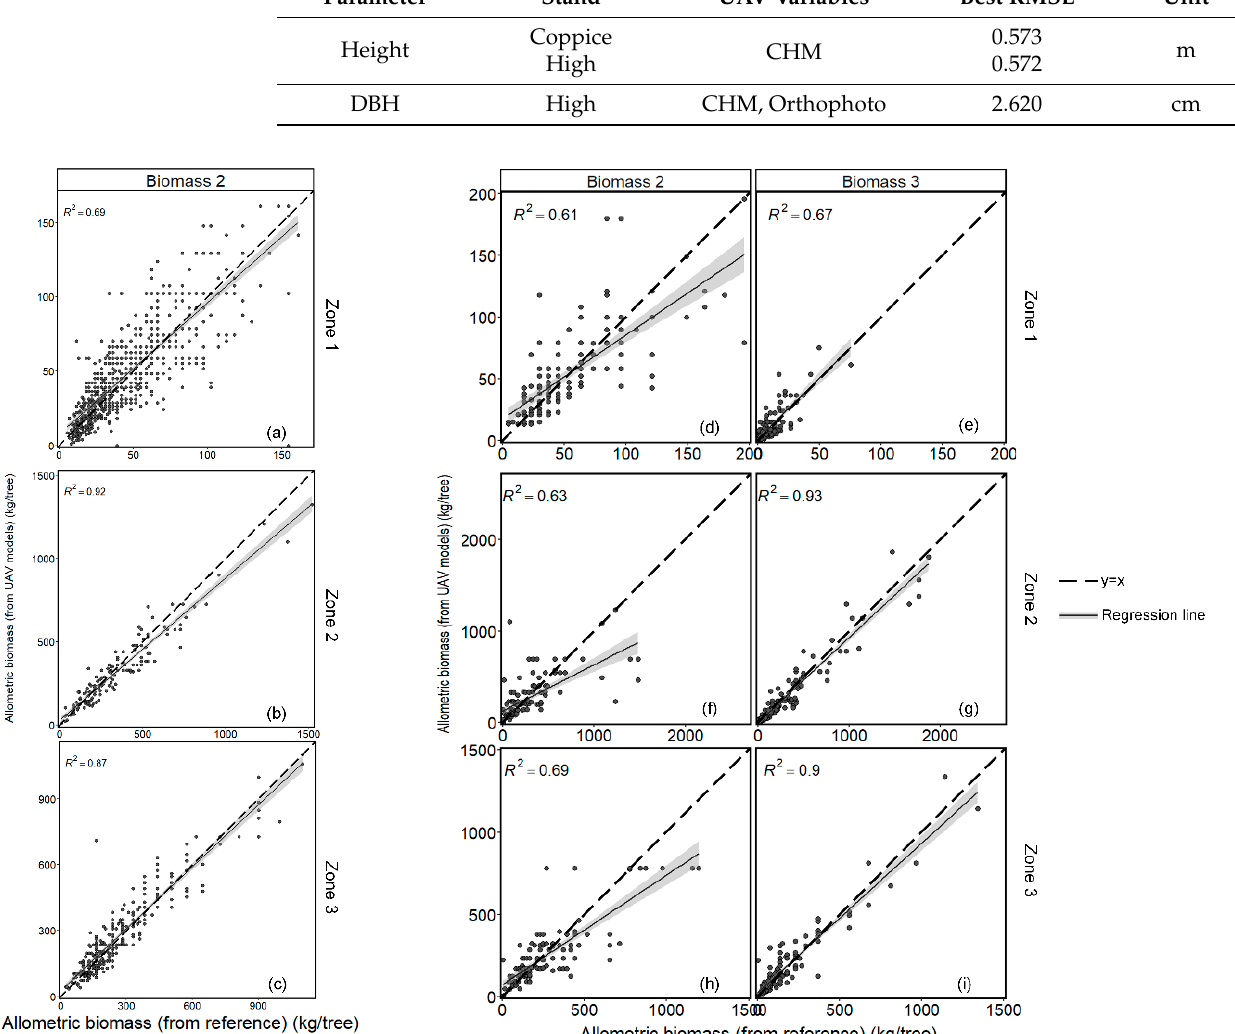
Figure 6. Biomass values obtained from allometric equations on variables measured by UAV (vertical axis) and reference values (horizontal axis) in coppice stands ( a – c ) and high stands ( d – i ).